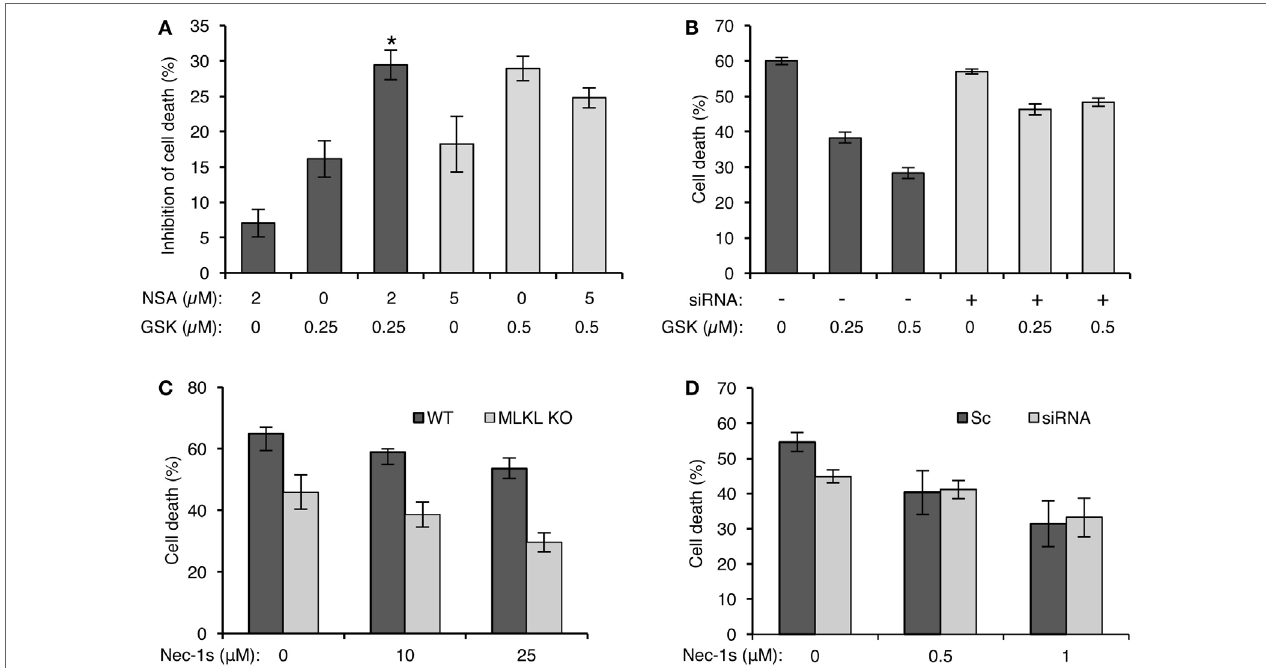
FigUre 5 | Mixed lineage kinase domain-like protein (MLKL) cooperates with RIPK3 during complement-dependent cytotoxicity (CDC) but not with receptor- interacting protein kinase 1 (RIPK1). (a) K562 cells were pretreated with GSK’872 and/or necrosulfonamide (NSA) in the indicated concentrations or with DMSO as control (0), for 1 h at 37°C, and then treated with antibody and complement for 1 h min at 37°C. The percentage of cell death (CD) was measured by propidium iodide (PI) inclusion. Results are expressed as the mean percentage of the inhibition of CD ± SD and represent three independent experiments. * P < 0.01 relative to pretreatment with 0.25 µM GSK’872 without NSA or to 2 µM NSA without GSK’872. [% Inhibition = (% Death of Control − % Death of Treatment)/%Death of Control × 100]. (B) K562 cells were transfected with Smart Pool siRNA targeting MLKL (siRNA) or scrambled siRNA (Sc) as a control by electroporation. After 24 h, the cells were treated with GSK’872 at the indicated concentrations (or DMSO as control, 0) and then with antibody and complement for 1 h at 37°C. CD was measured as above. Statistical analysis showed that CDC of MLKL knocked down cells is significantly less sensitive to GSK’872 than is CDC of cells treated with a scrambled siRNA (two-way-ANOVA, P < 0.001). (c) WT and MLKL KO mouse embryonic fibroblasts (MEFs) were treated with necrostatin-1 (Nec-1s), a selective RIPK1 inhibitor, in increasing concentrations, or with DMSO as control, for 1 h followed by incubation with 10% normal human serum (NHS). The lysis percentage was determined by PI inclusion. Results are presented as the mean percentage of lysis ± SD. Statistical analysis showed that MLKL KO MEF is as sensitive to CDC as WT MEF (two-way-ANOVA, P = 0.538). (D) MLKL-silenced K562 cells were treated with Nec-1s at the indicated concentrations and then with antibody diluted 1:18 or 1:15 for scrambled or siRNA-treated cells, respectively, followed by complement (NHS, 50%). CD was measured by PI staining, expressed as a